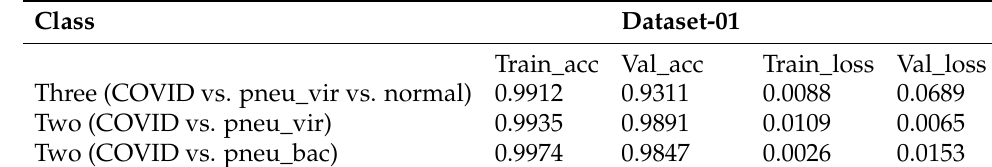
Table 8. Training and validation results for different classes.